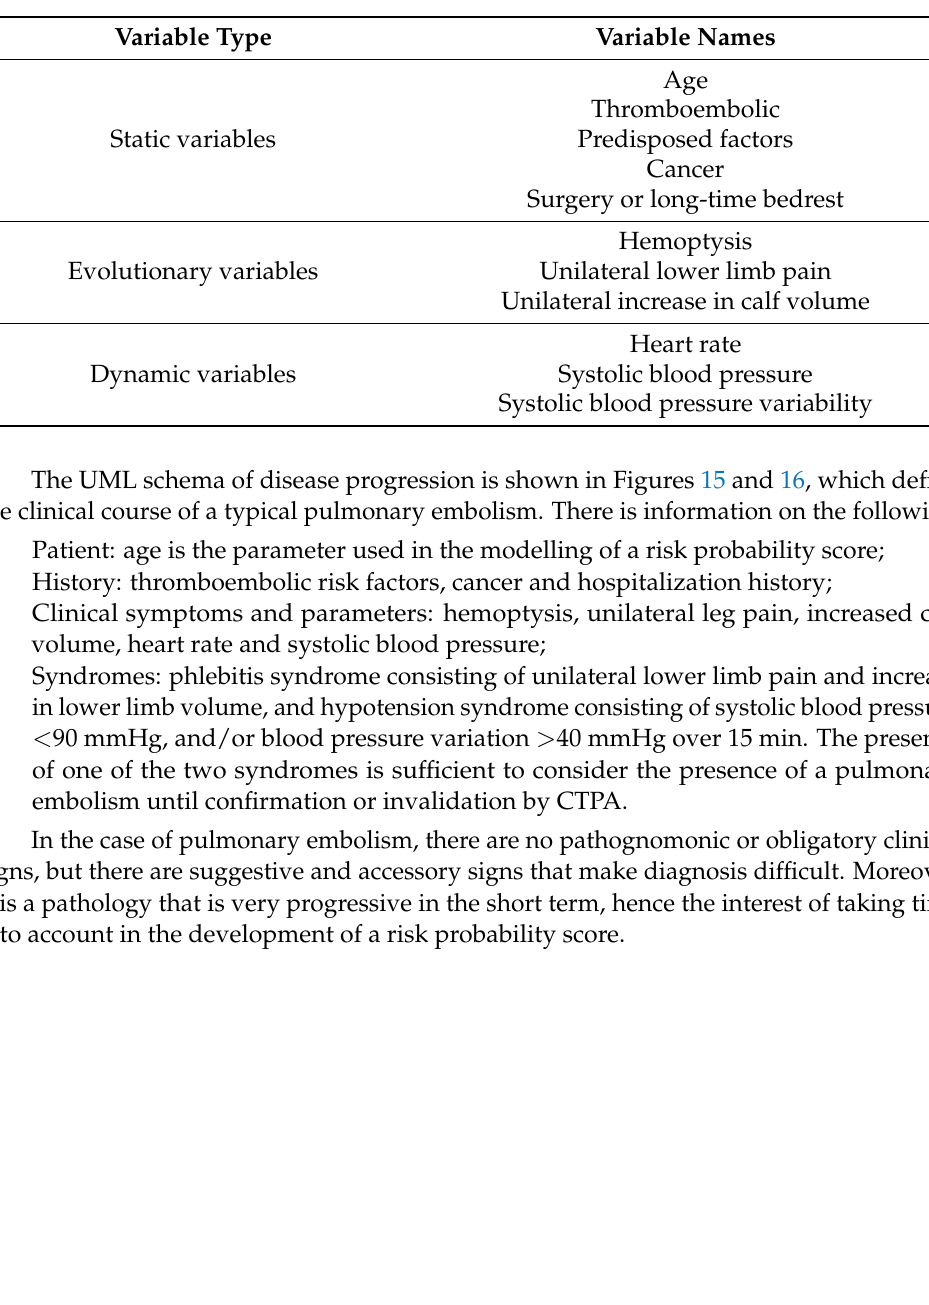
Table 2. Types of variables used in the FVSOOM model for